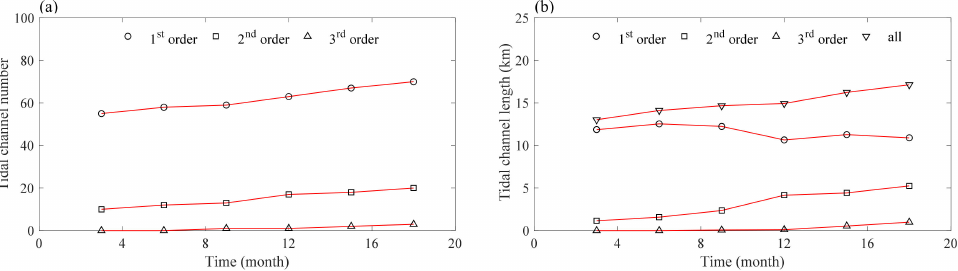
Figure 14. Variations of the tidal channel ( a ) number and ( b ) length, for all orders.